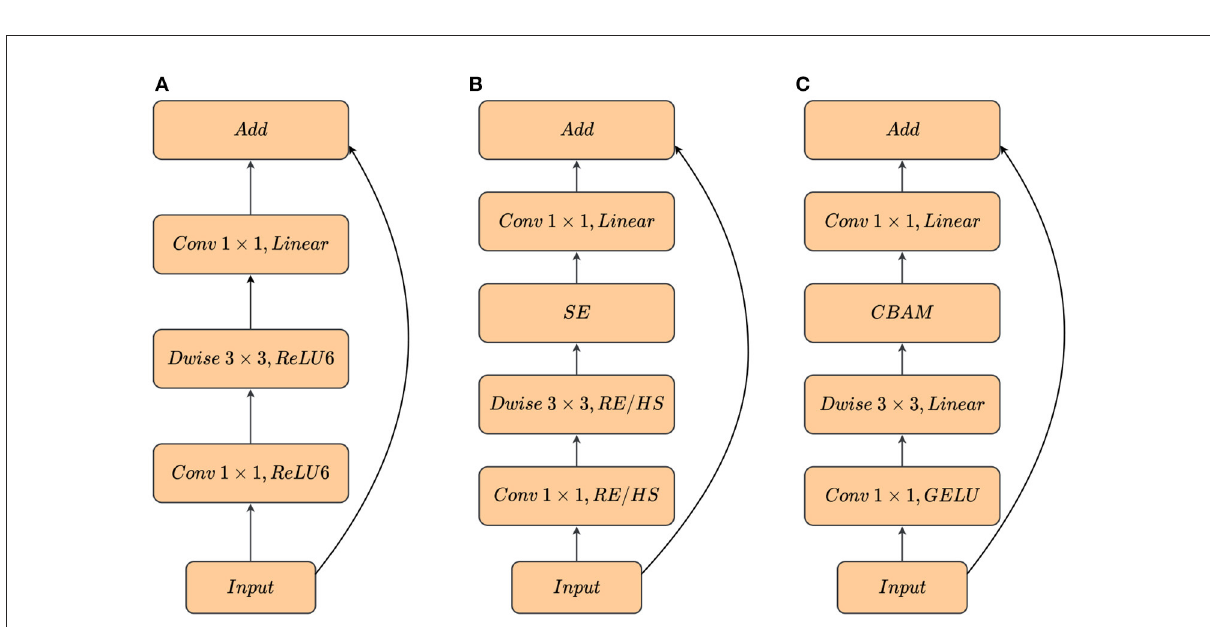
FIGURE4 The structure of the Convolutional block attention module. Channel Attention Module and Spatial Attention Module sequentially refine feature maps. denotes the multiplication of the input feature maps by the corresponding attention module. N